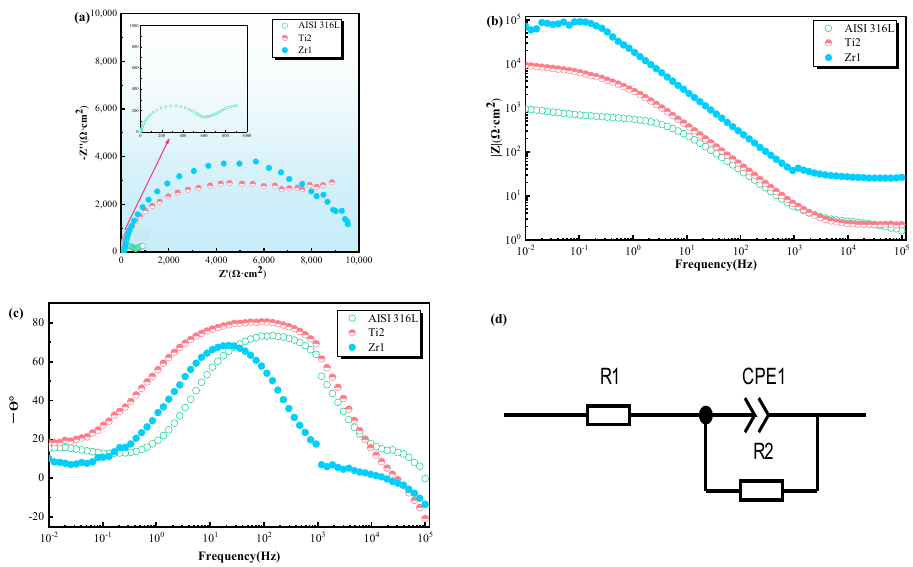
Figure 7. EIS of the AISI 316L, Ti2, and Zr2 specimens in 20 wt.% HNO 3 solution: ( a ) Nyquist plot; ( b , c ) Bode plots; ( d ) equivalent circuit plot. Table 4. Parameters of the AC impedance spectrum of the material measured in 20 wt.% HNO 3 solution.